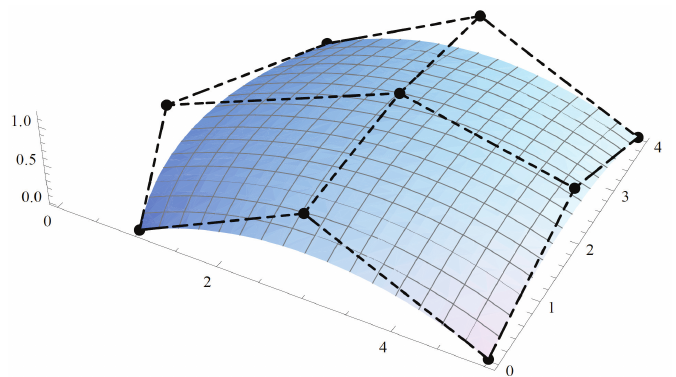
Figure 5. Defuzzification of Figure